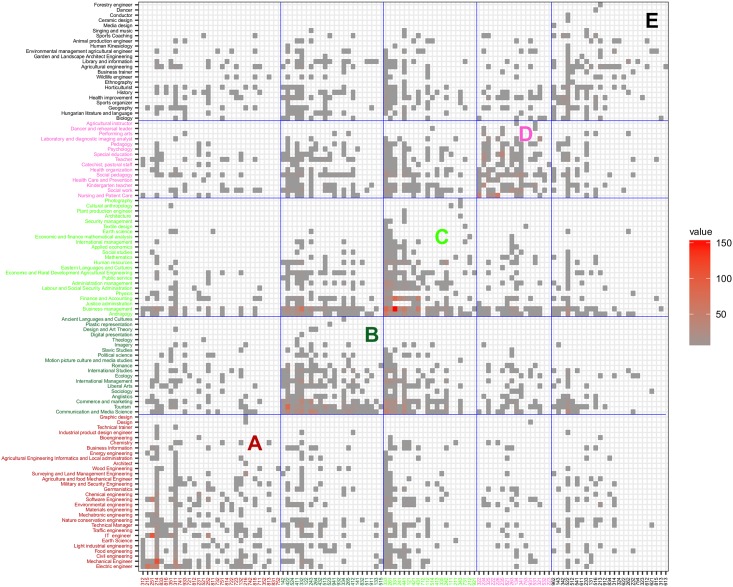
The modules obtained by the Louvain algorithm of purified program/occupation bipartite graph.